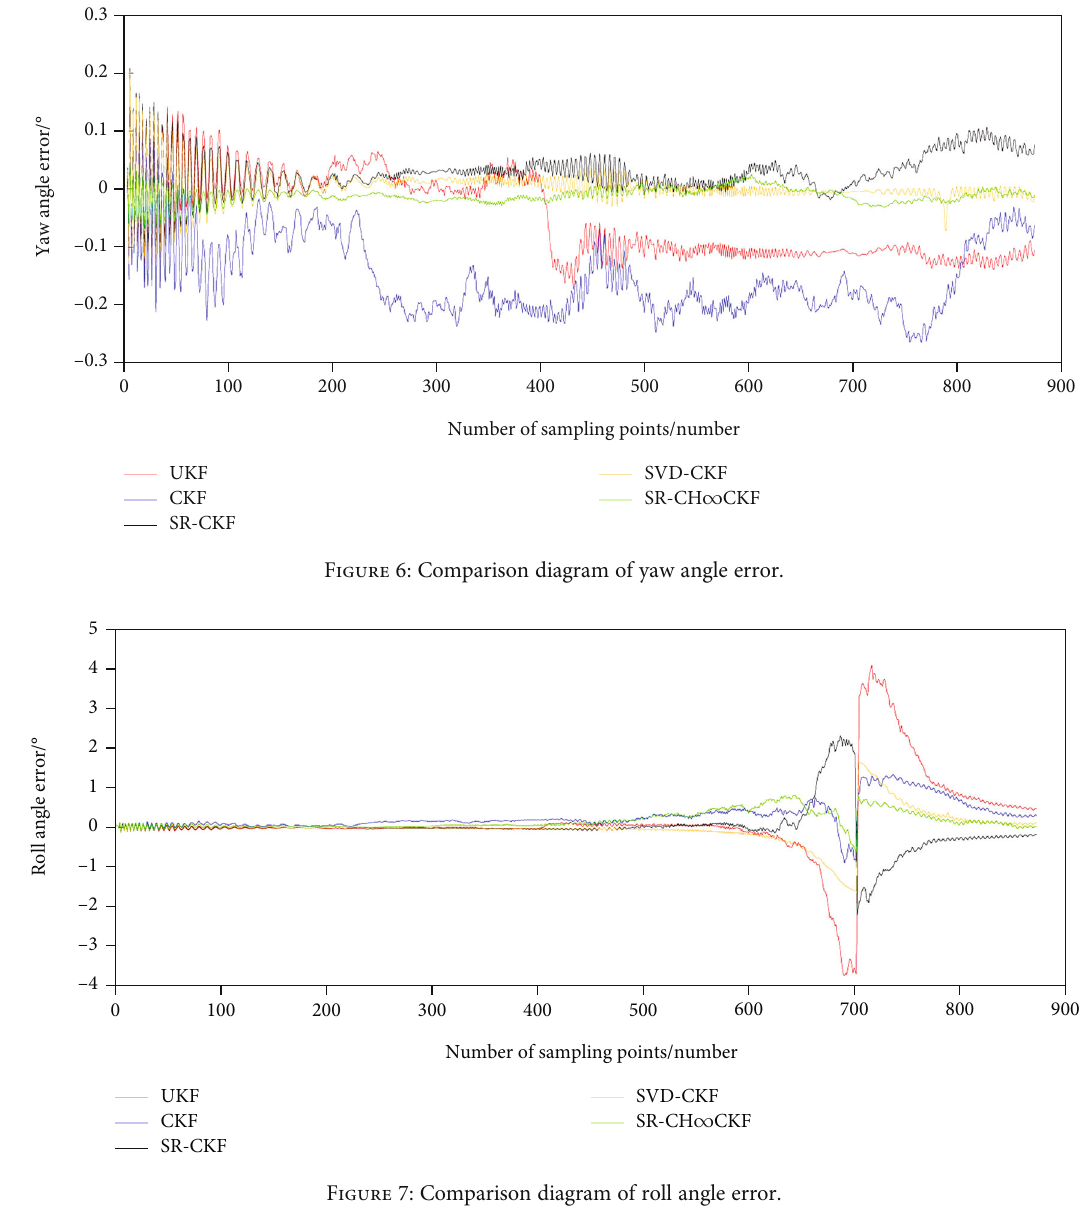
Figure 7: Comparison diagram of roll angle